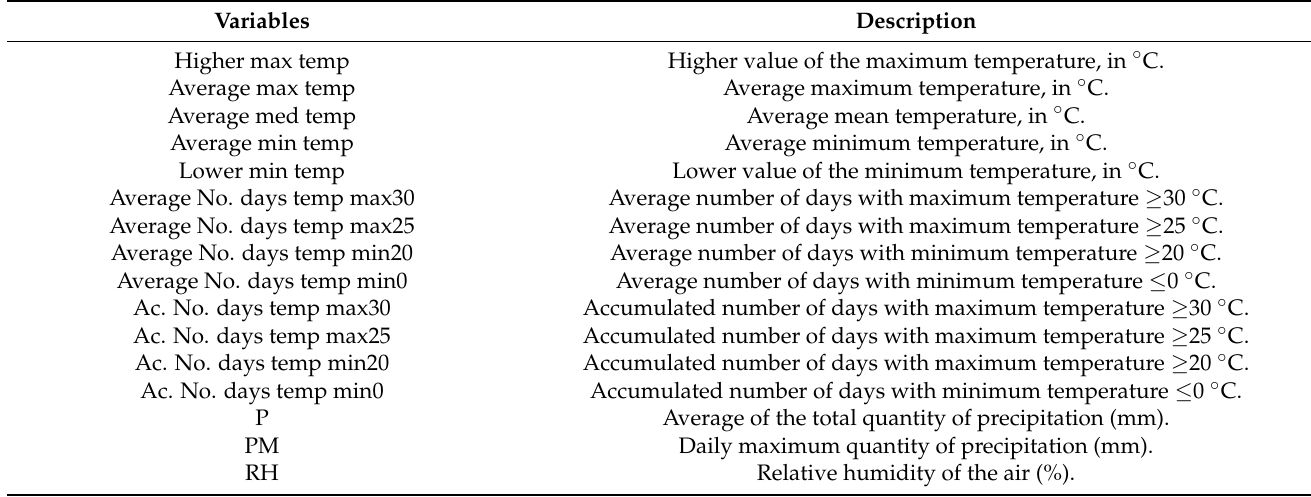
Table 3. Explanatory variables concerning the climate conditions corresponding to the month in which friction was measured and the zone or district where it is inserted.